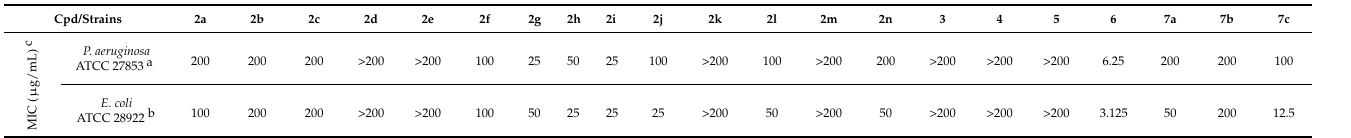
a Concentration of the selected compound necessary to restore doxycycline activity used at 2 µ g/mL. b Concentra- tion of the selected compound necessary to restore erythromycin activity used at 2 µ g/mL. c Values are mean of triplicate